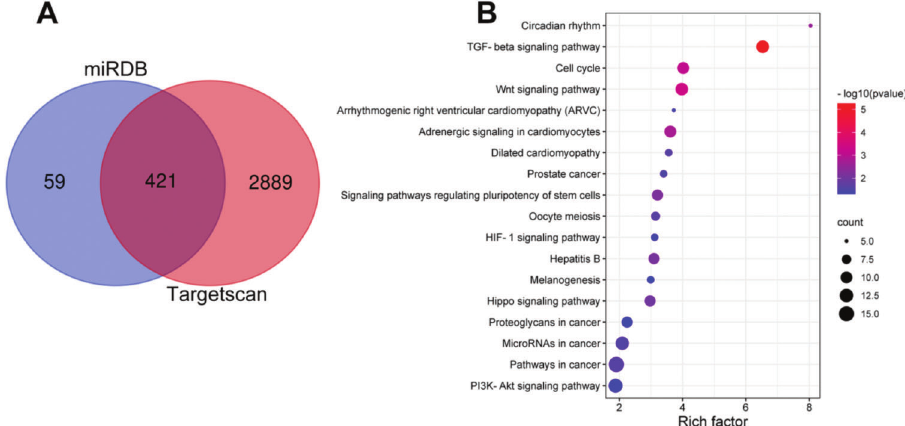
Figure S1 - The prediction and functional annotation of target genes for microRNA (miR)-582-3p. (A) Venn diagrams showing the intersection between the predicted target genes of miR-582-3p from the two databases. (B) Kyoto Encyclopedia of Genes and Genomes (KEGG) pathway enrichment analysis of the target genes of